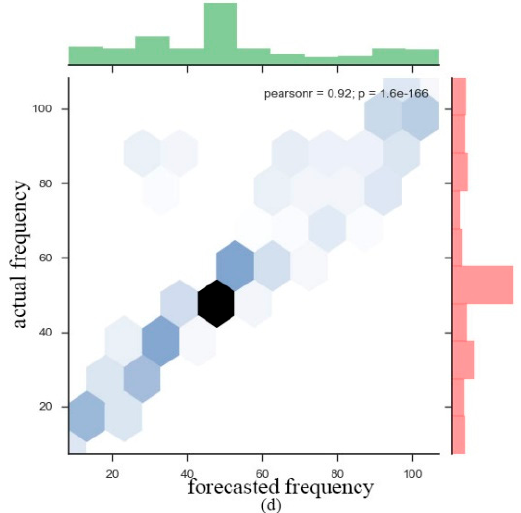
Figure 13. Jointplot of hex. Table 6. Analysis of Oscillation Mode of Wind Turbine on Forecasted Phase Current, Phase voltage and Power.